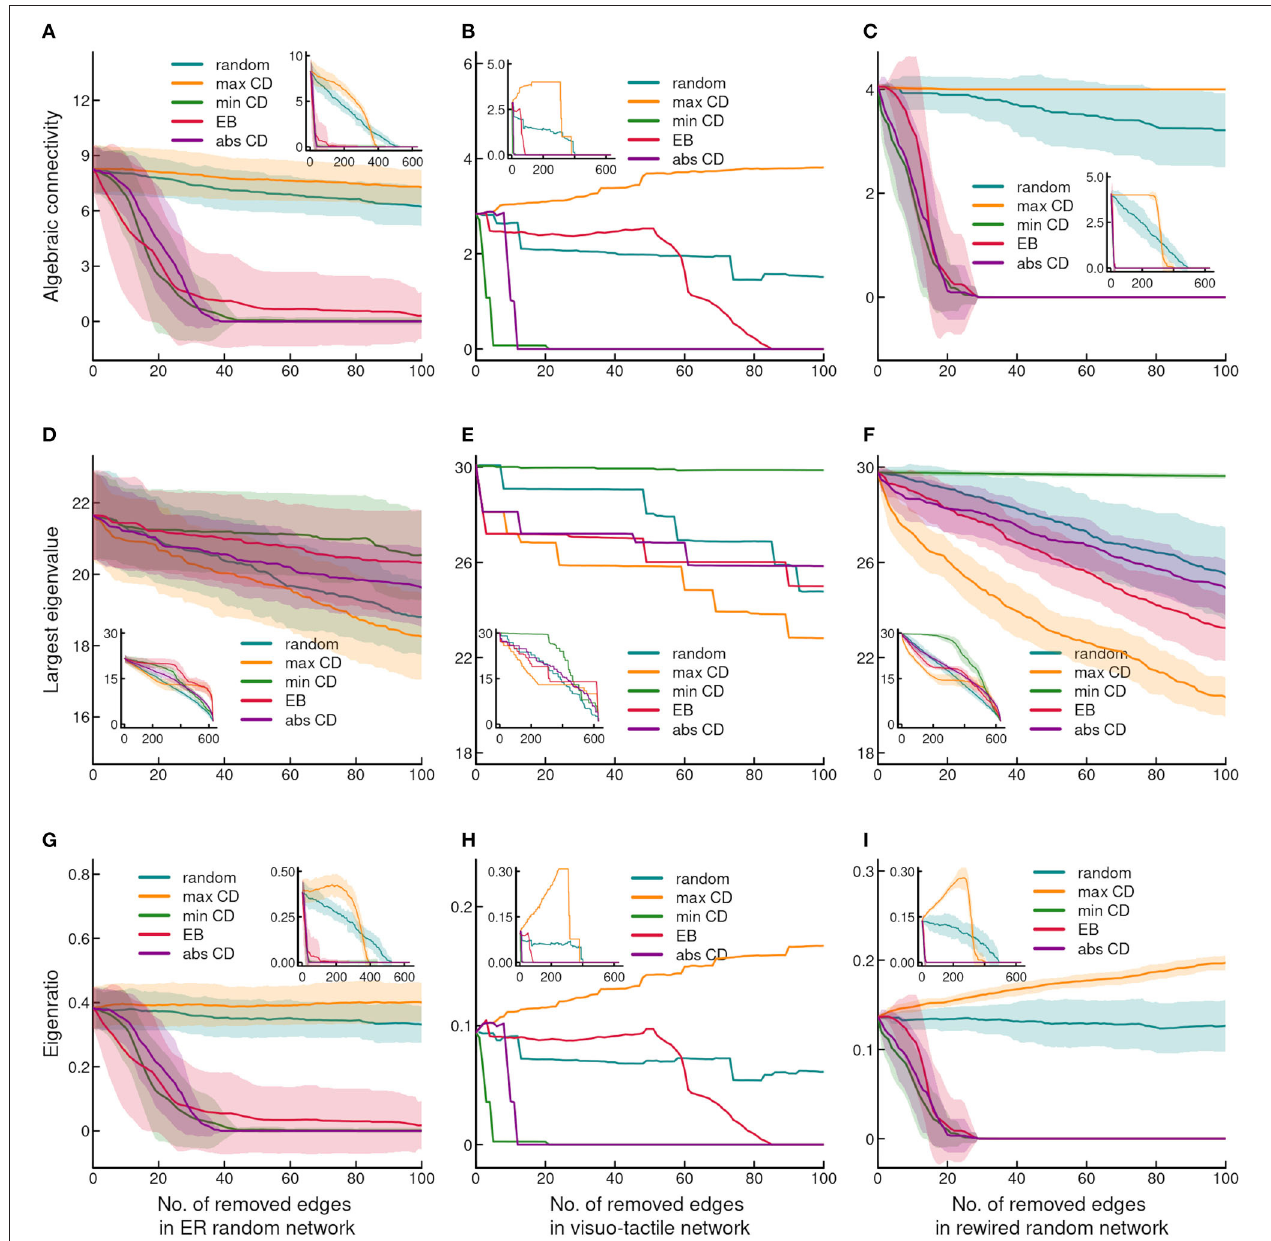
FIGURE 3 | Effect of edge removal on network integrity. (A–C) shows changes of the algebraic connectivity, (D–F) illustrate changes of the largest eigenvalue and (G–I) demonstrate changes of the eigenratio, as the function of stepwise edge removals. Note the almost identical pattern of changes of the algebraic connectivity and the eigenratio. The layout of the plots and the conventions are the same as in Figure 1